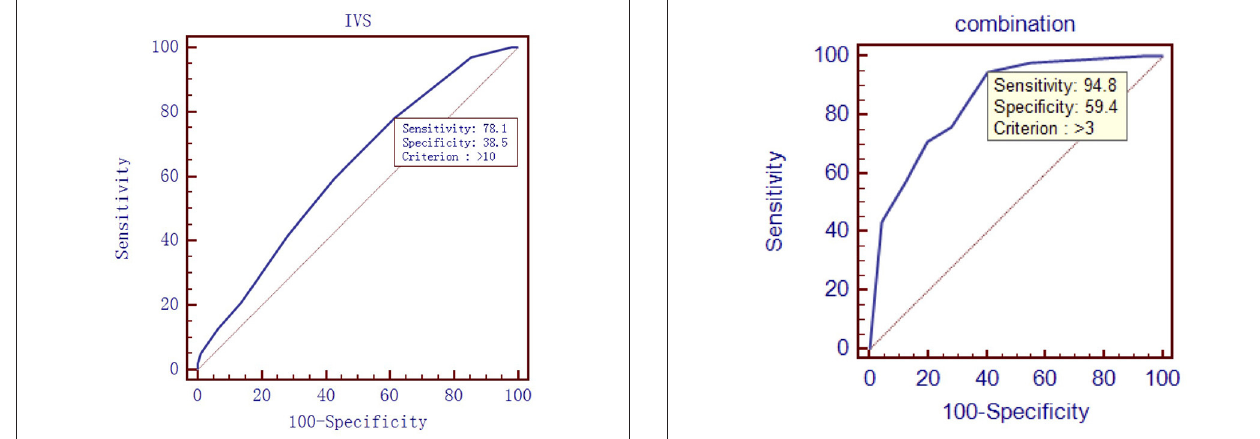
based on galectin-3 concentration. The AUC was 0.763 (95% confidence interval (C.I.), 0.696–0.821, P < 0.01), and galectin-